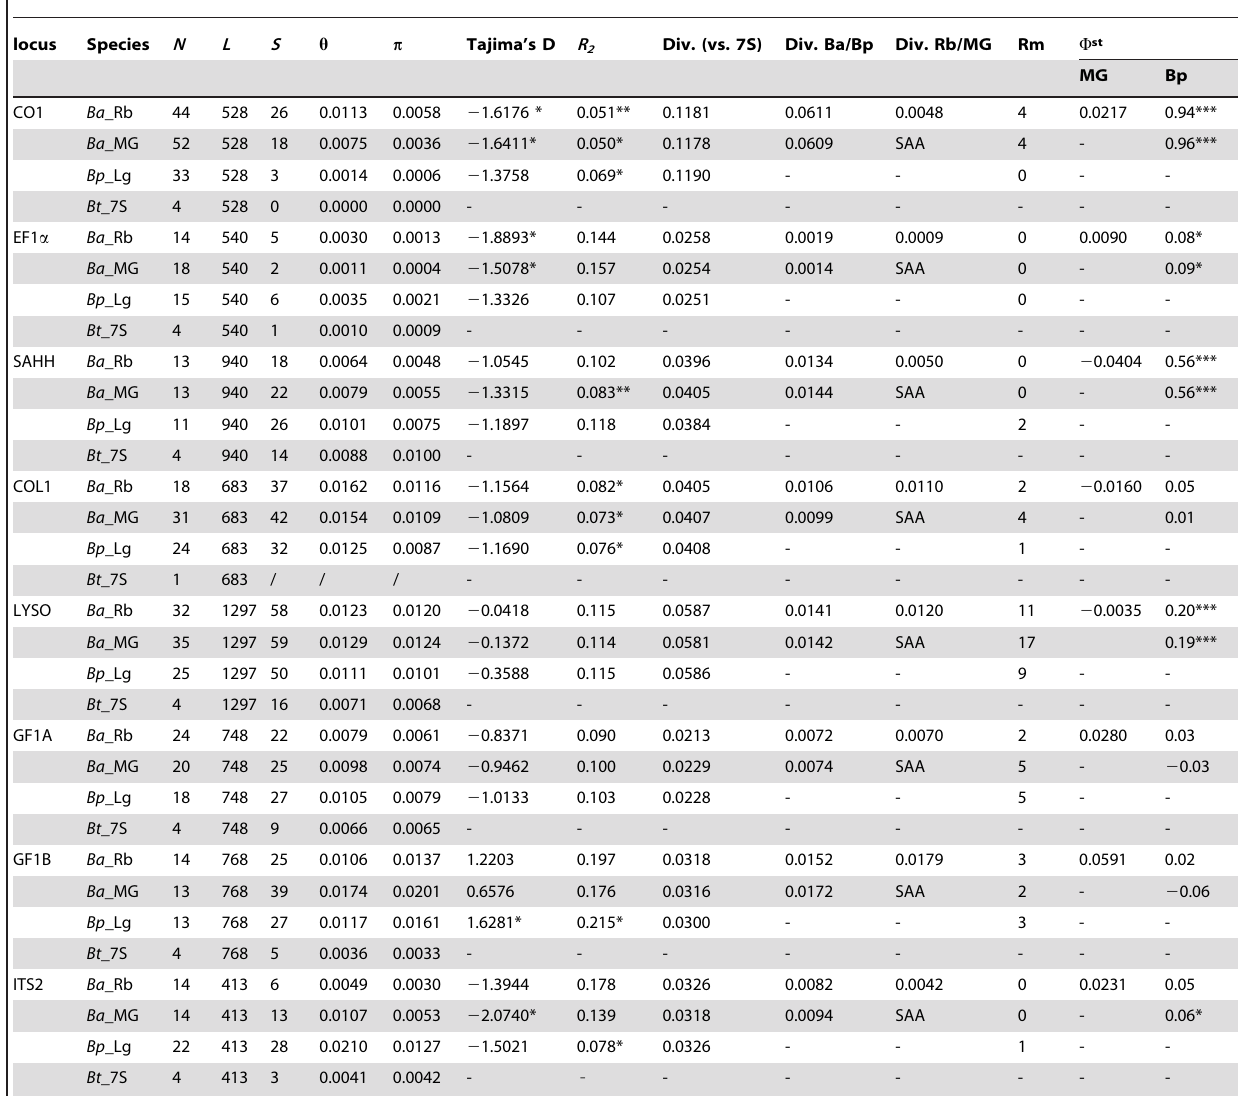
Table 2. Summary statistics of nucleotidic polymorphism for mitochondrial and nuclear sequences.